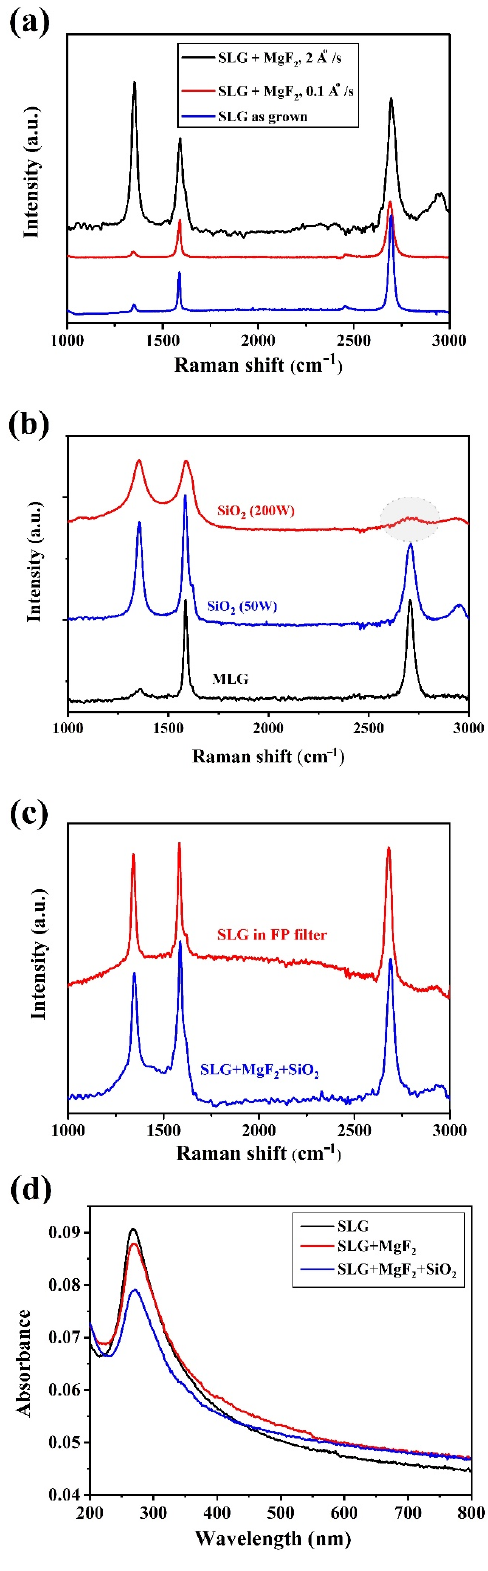
Figure 7. Raman spectra of: ( a ) SLG showing the effect of MgF 2 evaporation rate, ( b ) MLG showing the effect of SiO 2 sputtering conditions, and ( c ) SLG showing the effect of insertion inside the Fabry– Perot filter. ( d ) Comparison of absorbance of SLG pristine (as transferred on quartz substrate) and after MgF 2 evaporation and SiO 2 sputtering.